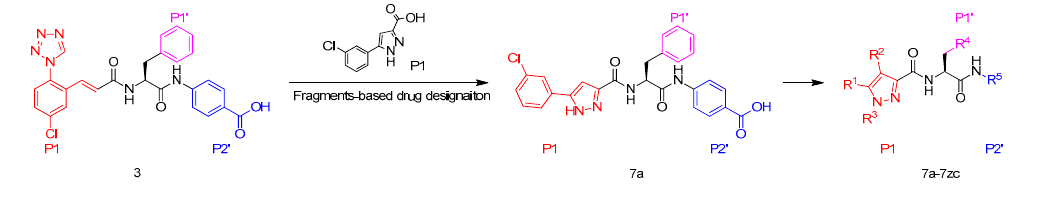
Figure 4. Design of FXIa inhibitors in present study.